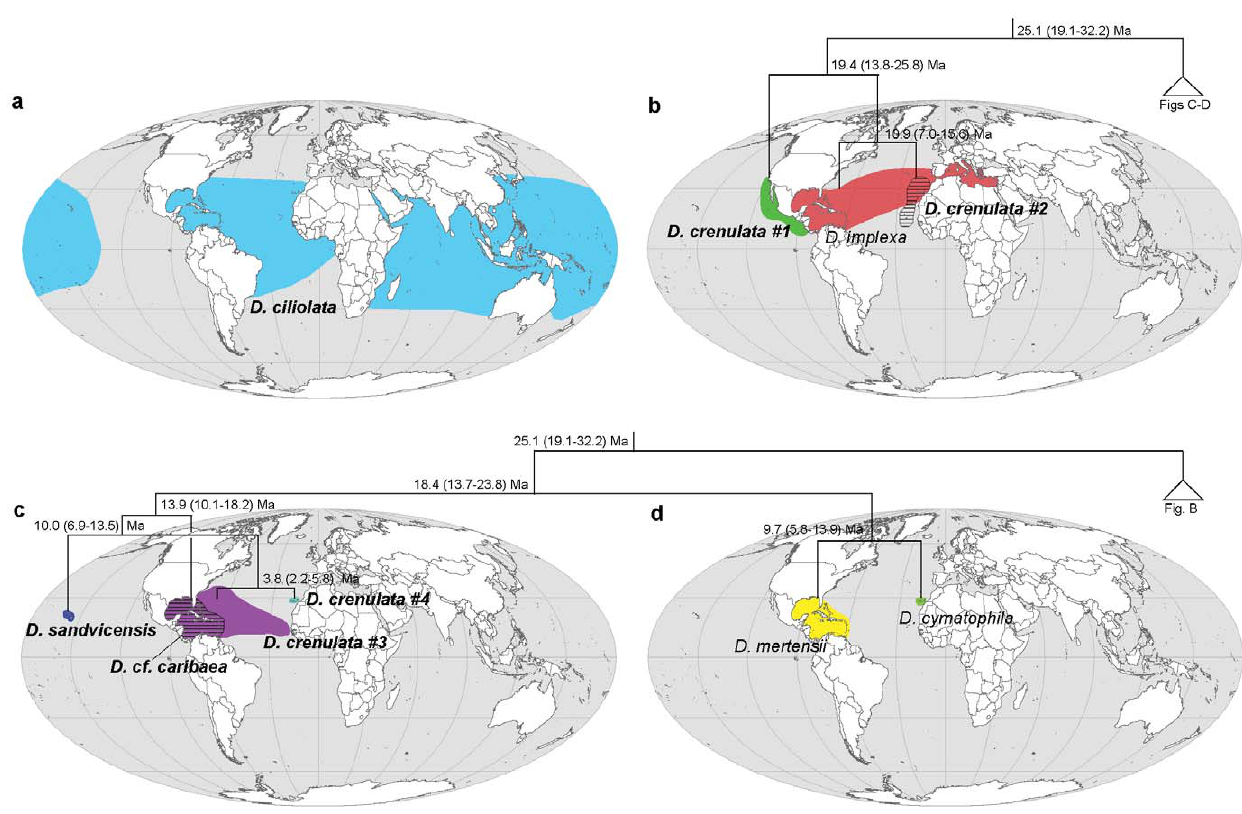
Figure 3. Distribution maps. Distribution of the species belonging to D. ciliolata (a) and the D. crenulata -complex (b–d) with superimposition of phylogenetic relationships.